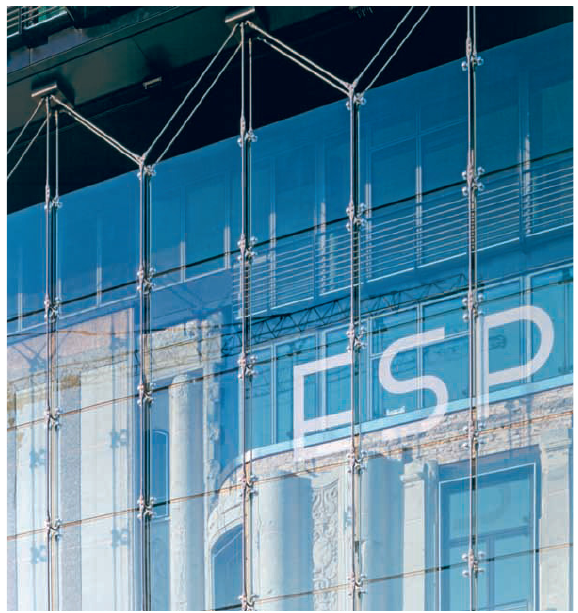
Figure 2: Sony Center – Hotel Esplanade,